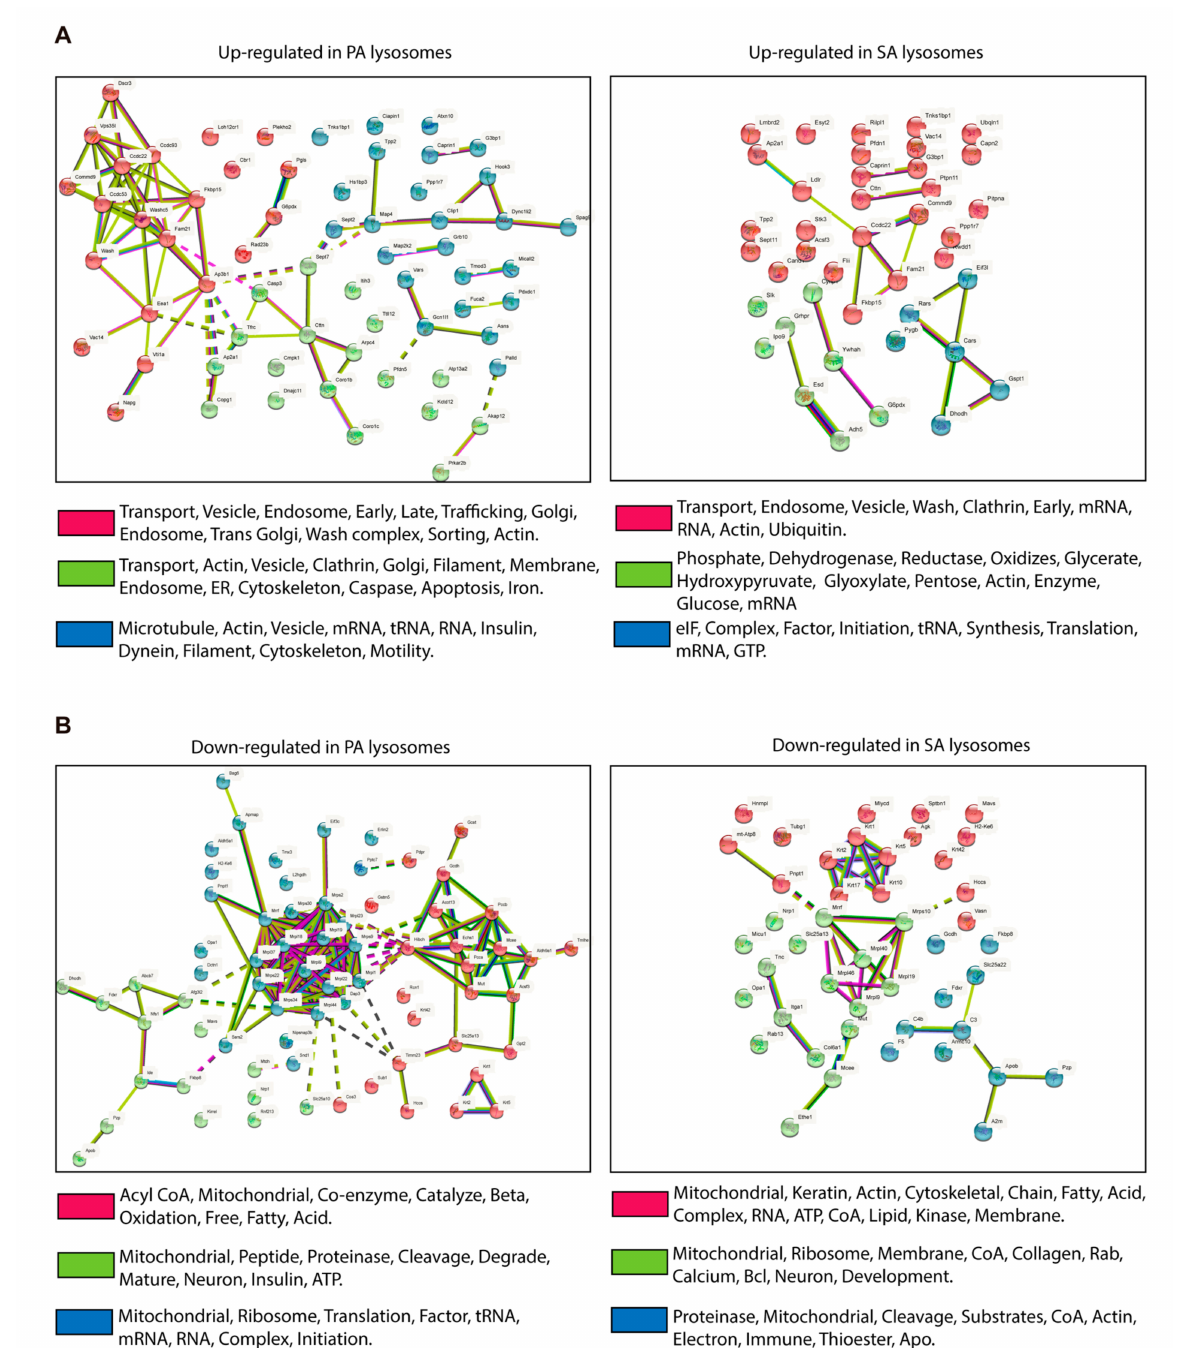
Figure 6. CMA-dependent pathways putatively affected in POMC-like neurons treated with PA and SA. The KFERQ-like motifs containing proteins (Figure 5B) that were found to be up- and downregulated were introduced in STRING (https://string-db.org, accessed on 9 February 2022) to analyze the cellular pathways in which they interacted in. Three interacting clusters were chosen (shown in red, green, and blue). ( A ) STRING outputs showing the principal pathways in which the upregulated proteins in PA and SA participated in. ( B ) STRING outputs showing the principal pathways in which the downregulated proteins in PA and SA participated